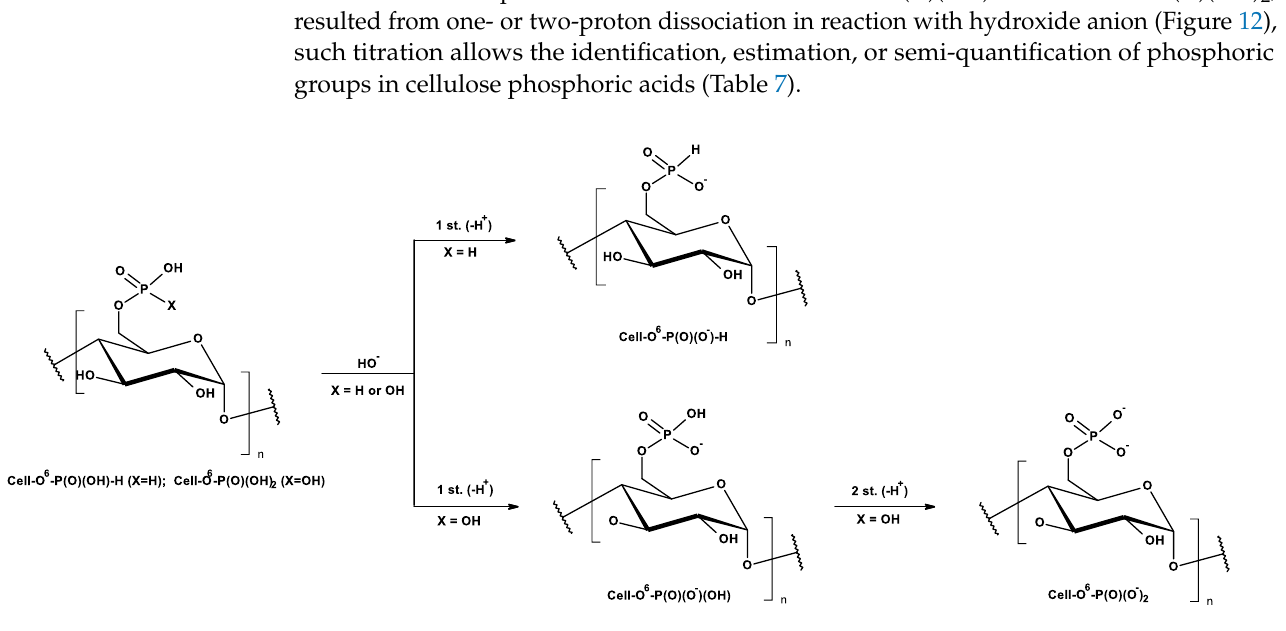
Figure 12. Schemes of alkalimetric titration of cellulose phosphoric acids. Table 7. Representative methods of potentiometric titration of cellulose- O -phosphoric acids. Potentiometric Titrations Cellulose- Phosphates Mode of Titration Defl. Points Cell- O -P(O)(OH)-H Direct titrations with KOH or LiOH Cell- O -P(O)(OH) 2